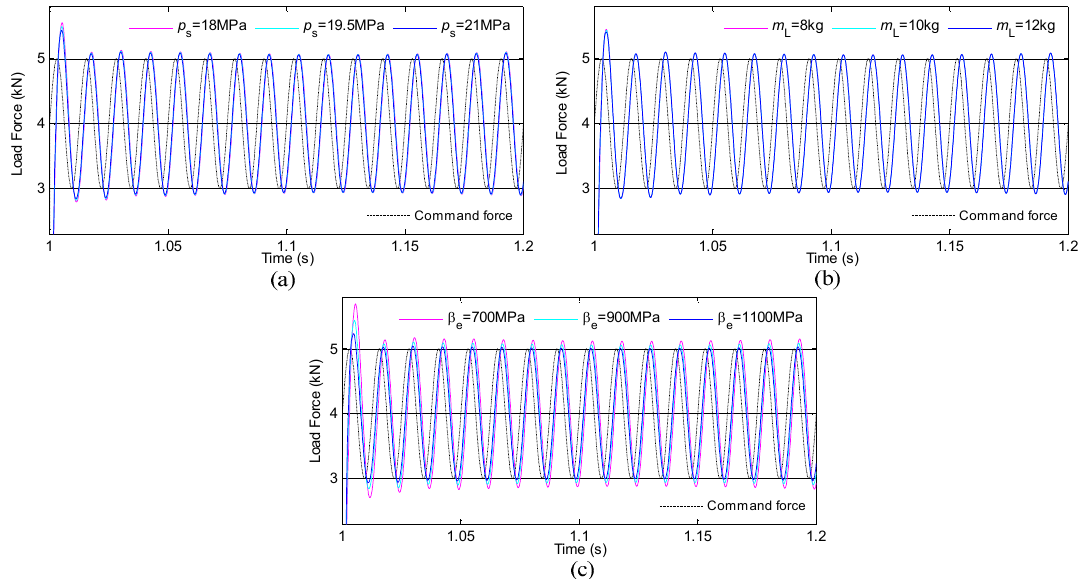
Figure 21. The loading performance of loading force 4 ` sin160 π t p kN q , ( a ) with perturbation of p s ; ( b ) with perturbation of m L ; ( c ) with perturbation of β e